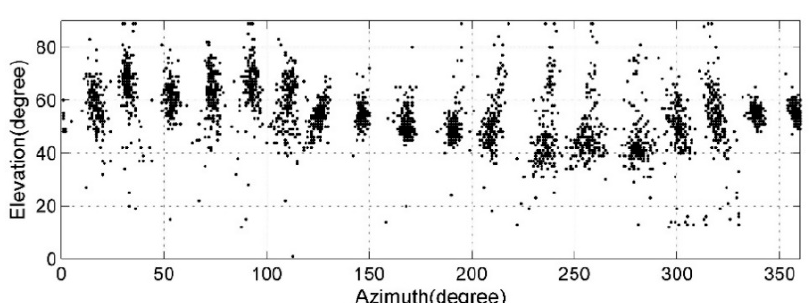
Figure 9. Sample points of the localization results (18 positions).